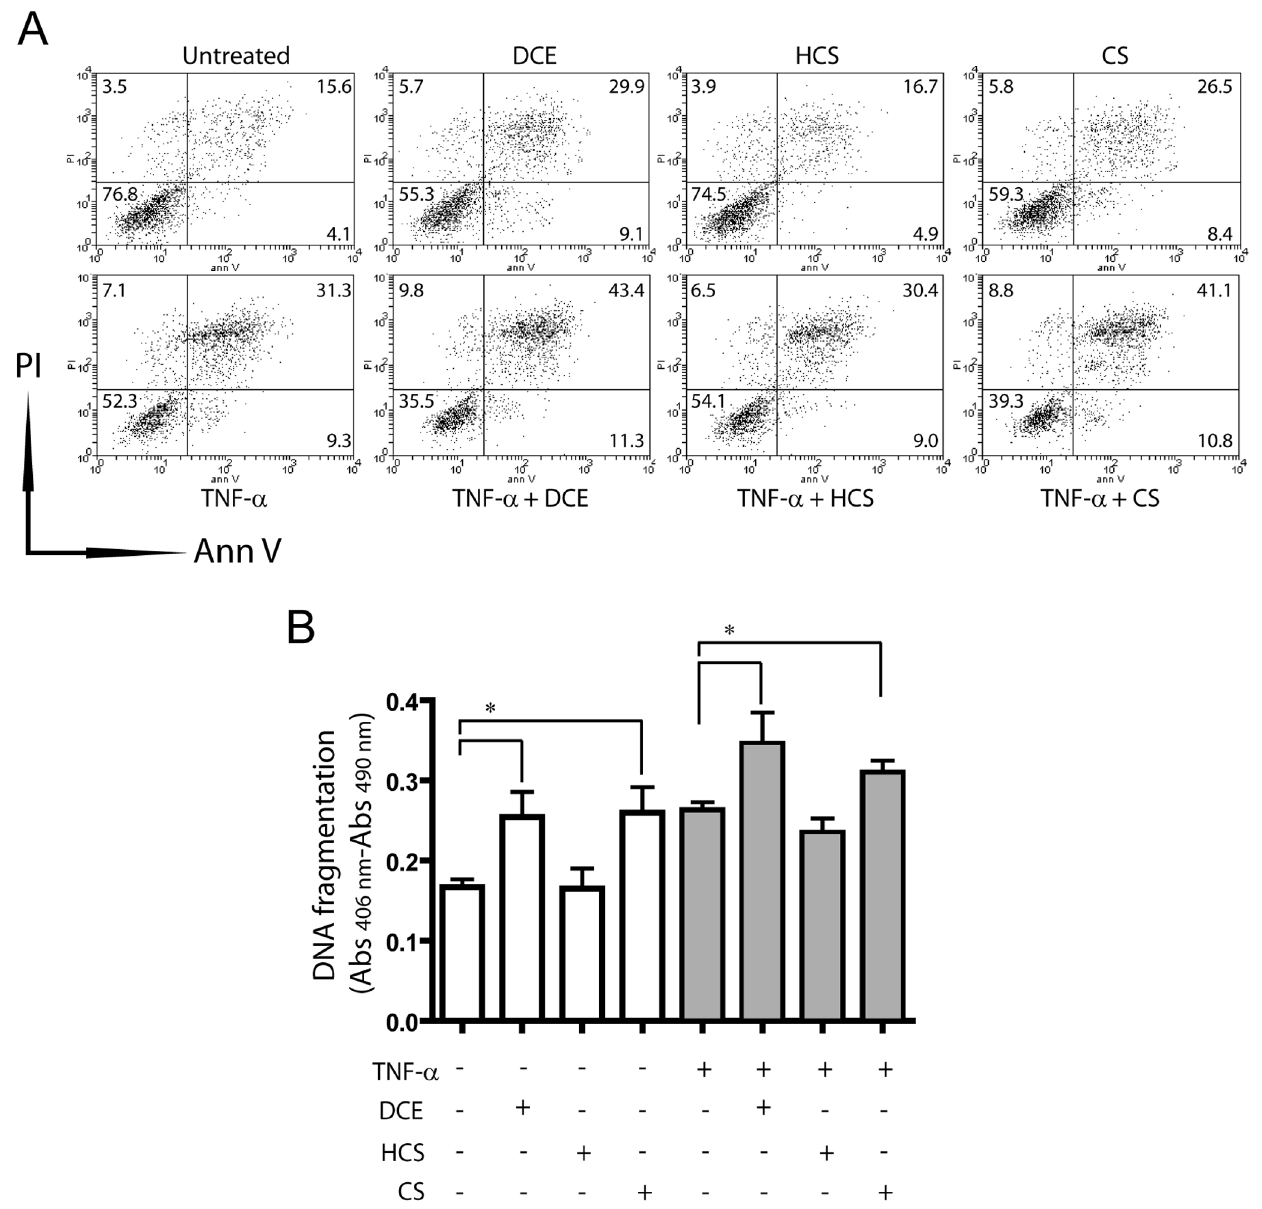
Figure 5. Apoptosis is enhanced in DCE- or CS-treated keratinocytes. Apoptosis of cultured keratinocytes treated with DCE, CS, or HCS in presence or absence of the pro-apoptotic stimulus TNF- a (50 ng/ml for 48 h) was examined by measuring Annexin/PI fluorescence through FACS analysis (A) or DNA fragmentation by ELISA (B). In A), a representative experiment of four performed is shown, with numbers indicating the percentage of PI + (upper left), Ann V + (lower right), PI/Ann V + (upper right), or negative (lower left) cells. In B), * p #